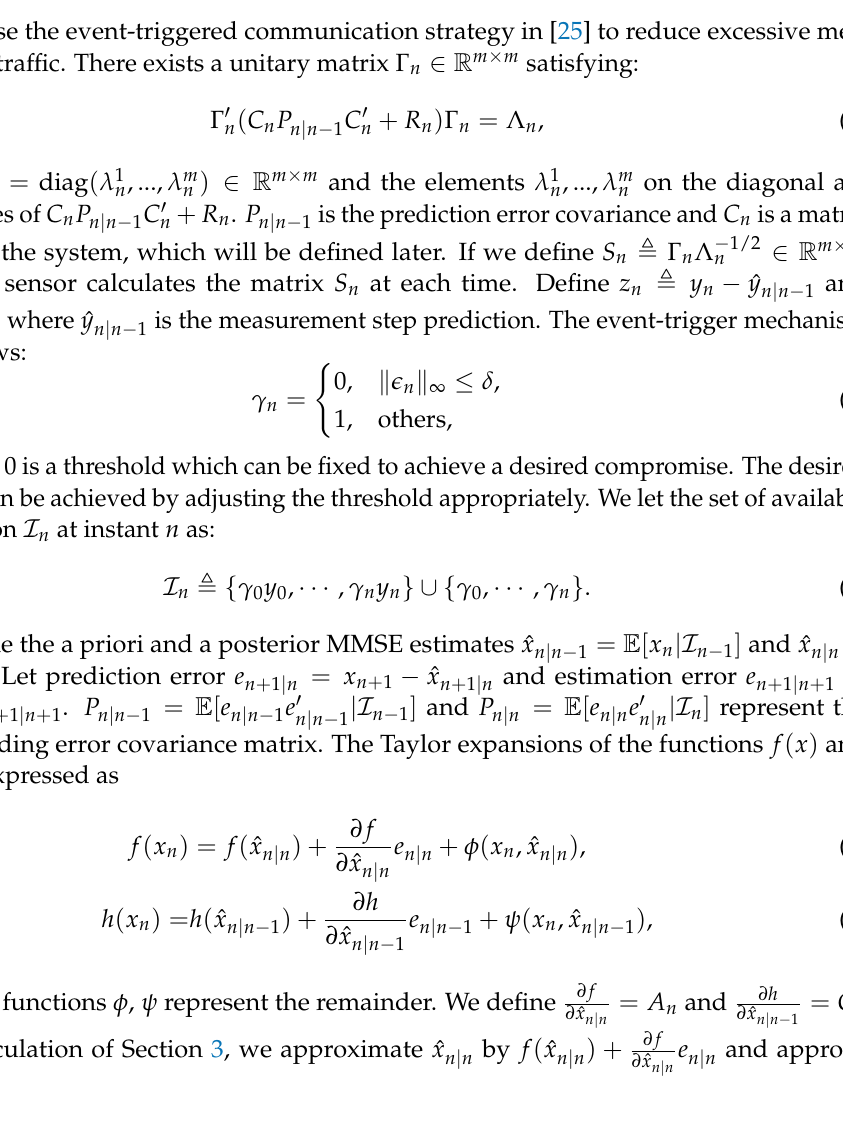
Figure 1. Networked system communication